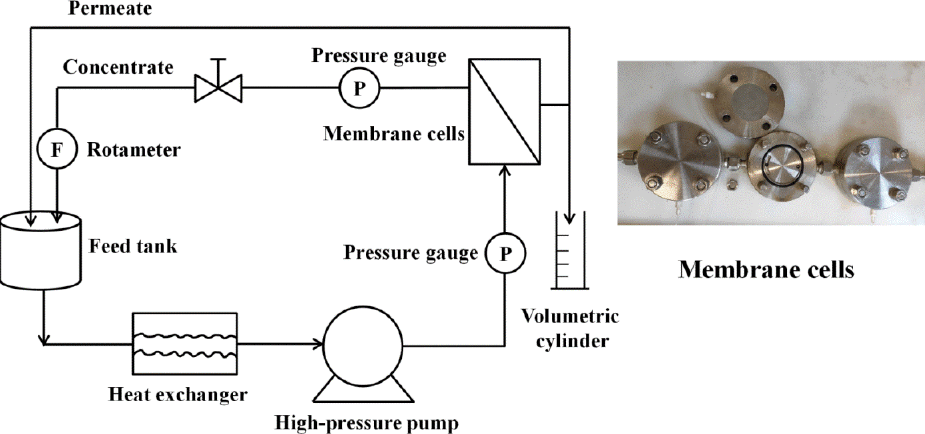
Figure 1. The schematic diagram of the cross-flow RO filtration apparatus.